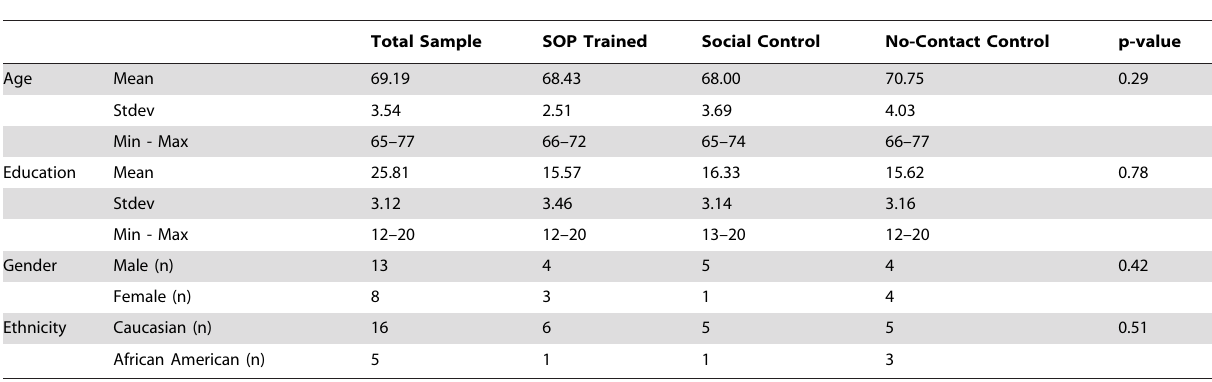
Table 1. Demographics for training groups.